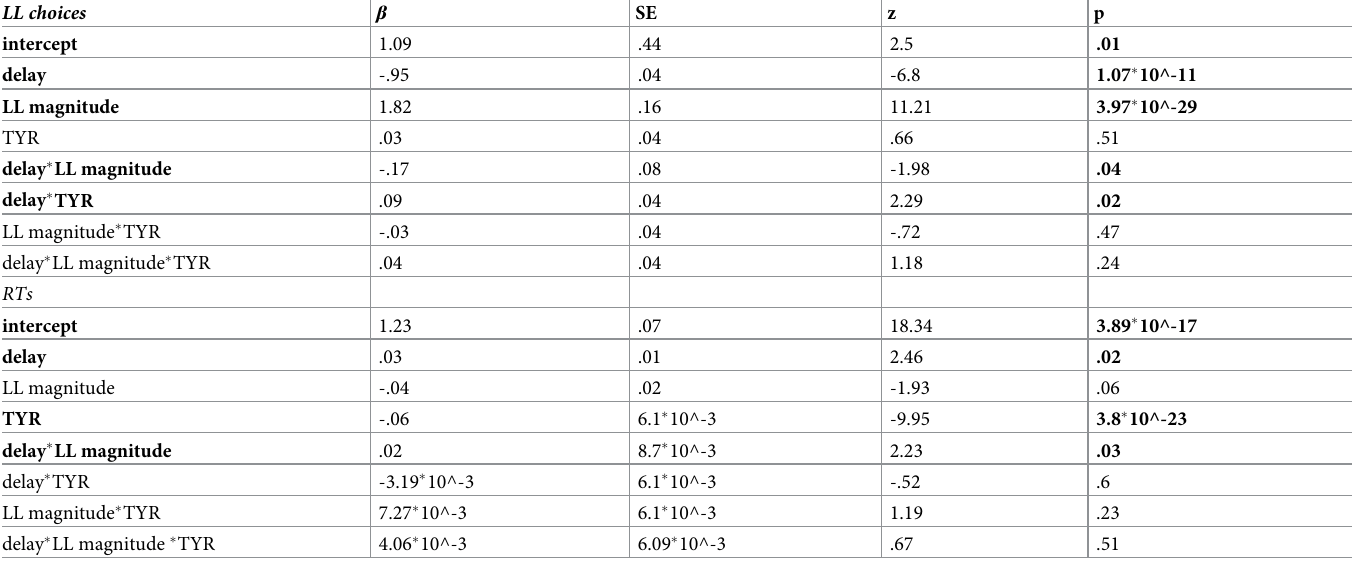
Table 4. Effects on the probability to choose the larger-but-later (LL) option in the temporal discounting task (N = 28) from a generalized mixed effects regression analysis (glmer model: choice(LL)~delay � LL magnitude � tyrosine + (delay � LL magnitude + 1 | participant)). And effects on participants’ RTs in the temporal discount-